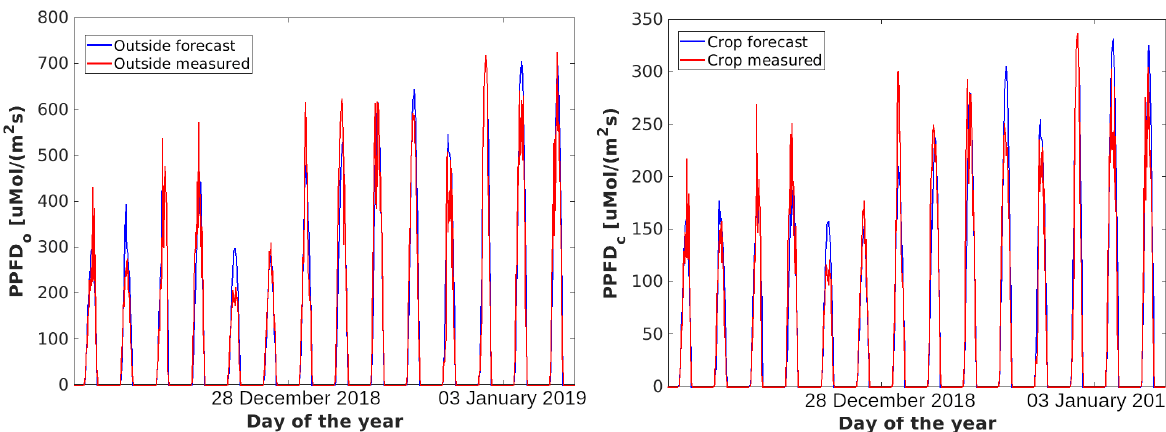
Figure 9. System identification. Red lines indicate the natural horizontal solar radiation. Dashed lines are the values estimated 24-h ahead by the proposed algorithm. The figure on the left indicates the outdoor solar radiation ( PPFD o ) measured and computed. The figure on the right indicates the solar radiation over the canopy ( PPFD c